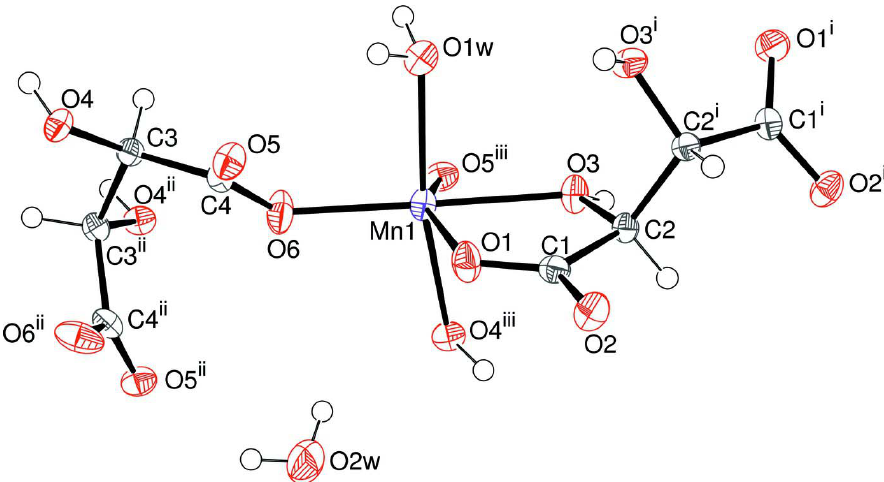
View of (I), showing displacement ellipsoids drawn at 50% probability level (arbitrary spheres for the H atoms). Symmetry codes: (i) - x , y , 1/2 - z ; (ii) 1 - x , y , 3/2 - z ; (iii) x , - y , z -